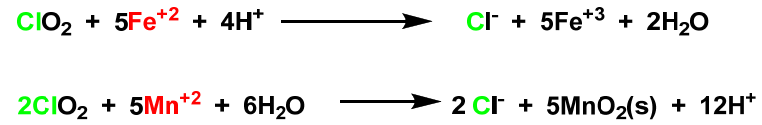
Figure 24. ClO 2 oxidizes Fe(II) and Mn(II) via rapid one ‐ electron transfer.